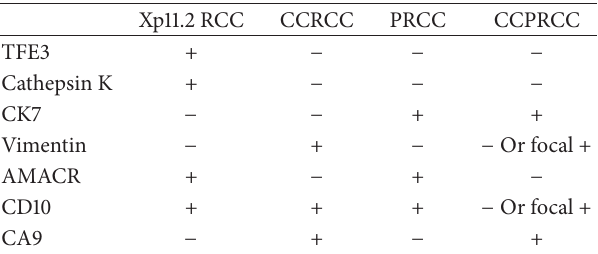
Table 2: The immunostain profiles of Xp11.2 RCC and its close